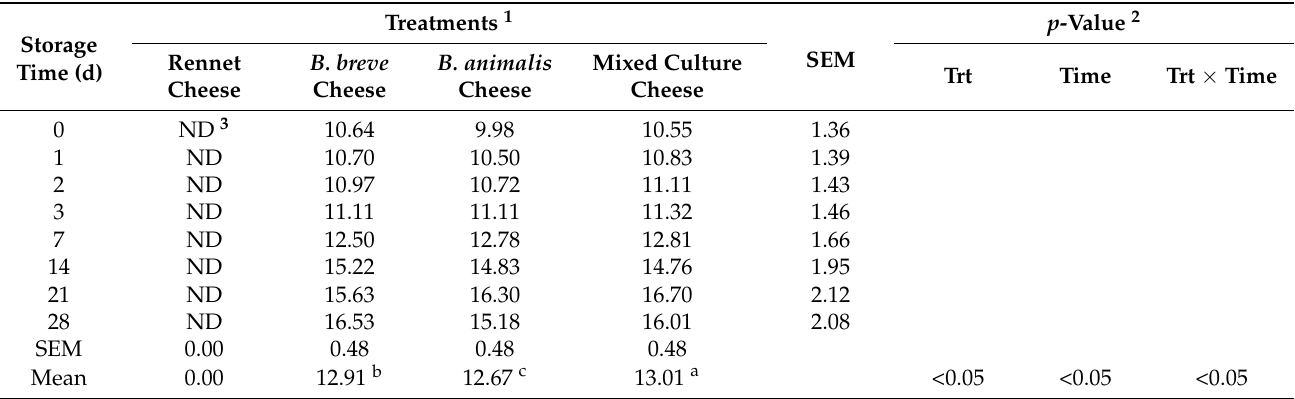
Table 4. Count of Bifidobacterium spp. (log cfu g − 1 ) in manufactured soft cheese stored at 4 ± 2 ◦